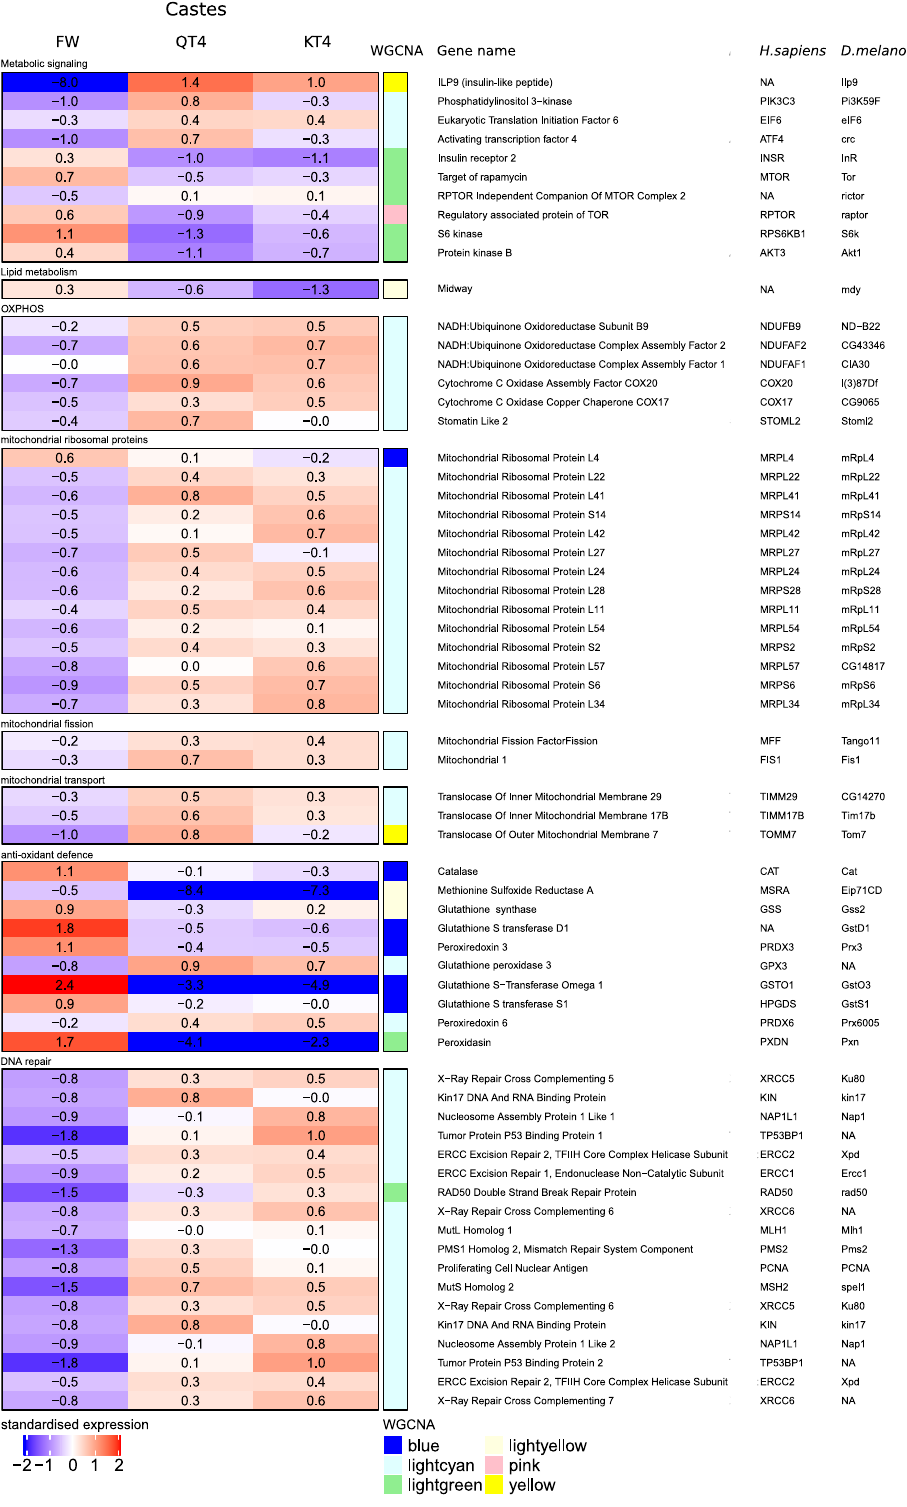
Fig. 3 Caste-related changes in gene expression. Heatmap representing standardized gene expression (blue = low; red = high) in fat bodies of FW, QT4, and KT4. Annotations to the right of the heatmap include the WGCN module (Supplementary Fig. 2), gene names and gene acronyms in Drosophila melanogaster ( D. melanogaster ) and Homo sapiens ( H. sapiens ). The map is restricted to the expression of genes involved in metabolic signaling, lipid metabolism, mitochondrial oxidative phosphorylation system (OXPHOS), mitochondrial ribosome proteins, mitochondrial fi ssion, mitochondrial transport, antioxidant defense, and DNA repair. Expression of all genes differs signi fi cantly between FW versus QT4 and between FW versus KT4. The number of replicates per group is provided in Supplementary Table